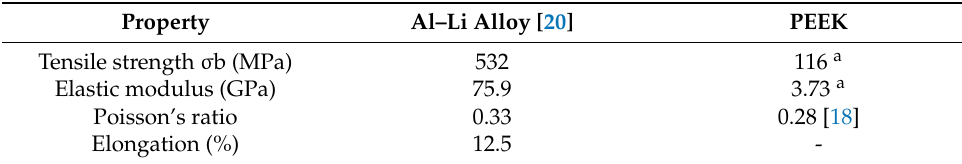
Table 2. Properties of the Al–Li alloy and the